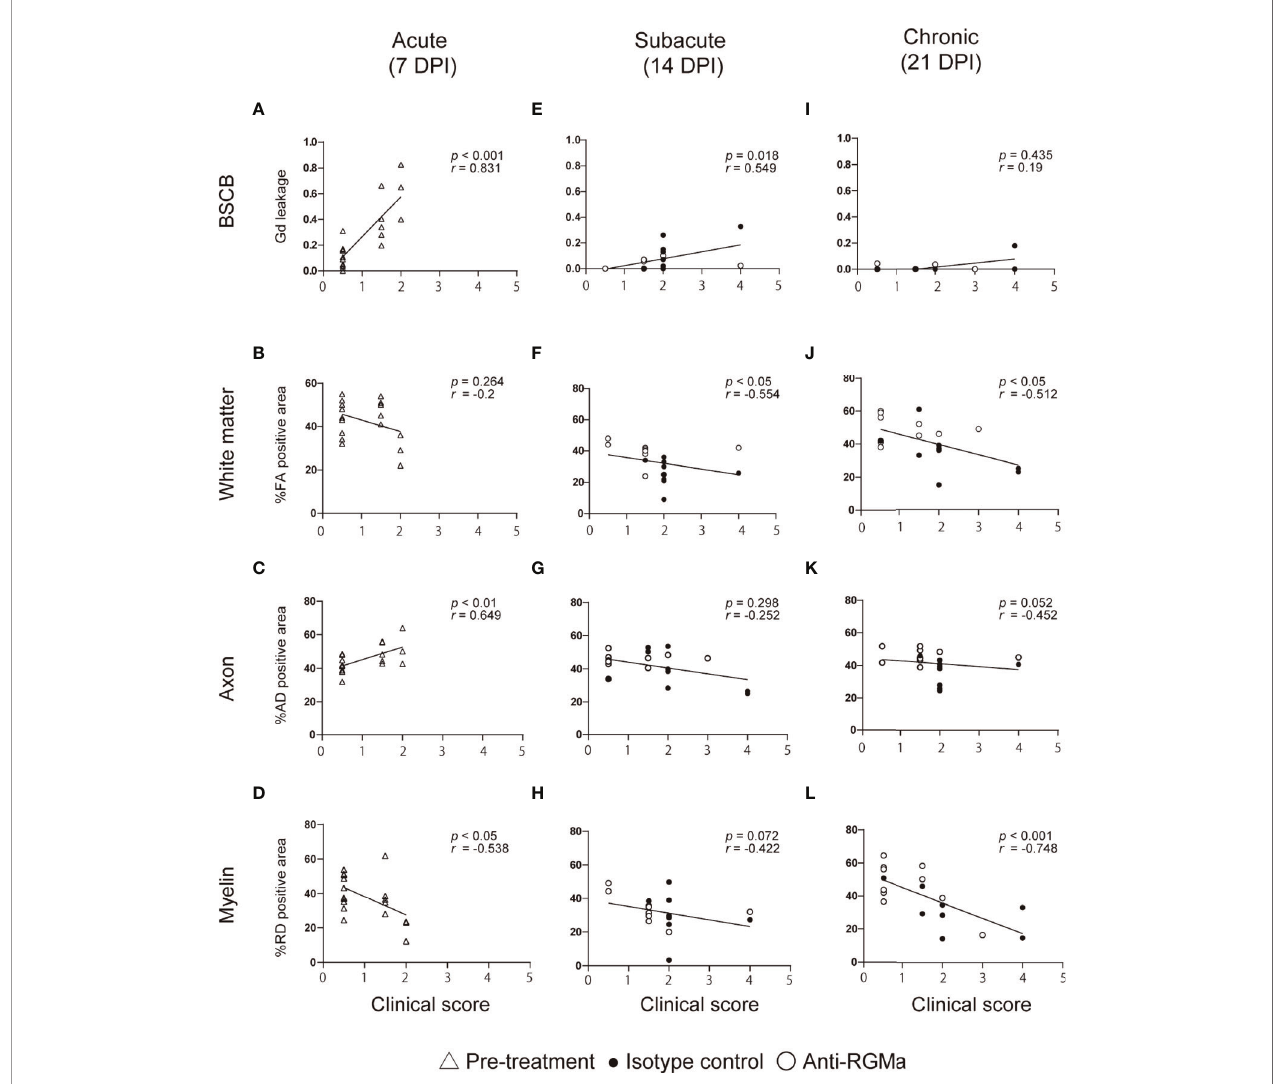
FIGURE 3 | The correlation between clinical score and MRI parameters at each time point. Each plot shows individual values of clinical score and MRI parameters at 7 DPI ( A – D , n=18-19), 14 DPI ( E – H , isotype control; n=9, anti-RGMa; n=9-10), and 21 DPI ( I – L , isotype control; n=9, anti-RGMa; n=9-10). The correlation coef fi cient and signi fi cance are expressed as r and p , respectively (Spearman ’ s correlation antibody groups ( Figure 5B ). The differentially expressed genes after the fi rst anti-RGMa antibody injection, Figure 5A ). Using ( p -value < 0.05 and fold change > 1.5, isotype control group v.s. pre-processed microarray data ( Supplementary File 2 ), anti-RGMa antibody group) were presented in volcano plot and principal component analysis was performed, and the result MA plot ( Figure 5C ), and the ranked gene list were used for shows clear difference among naïve, control, and anti-RGMa